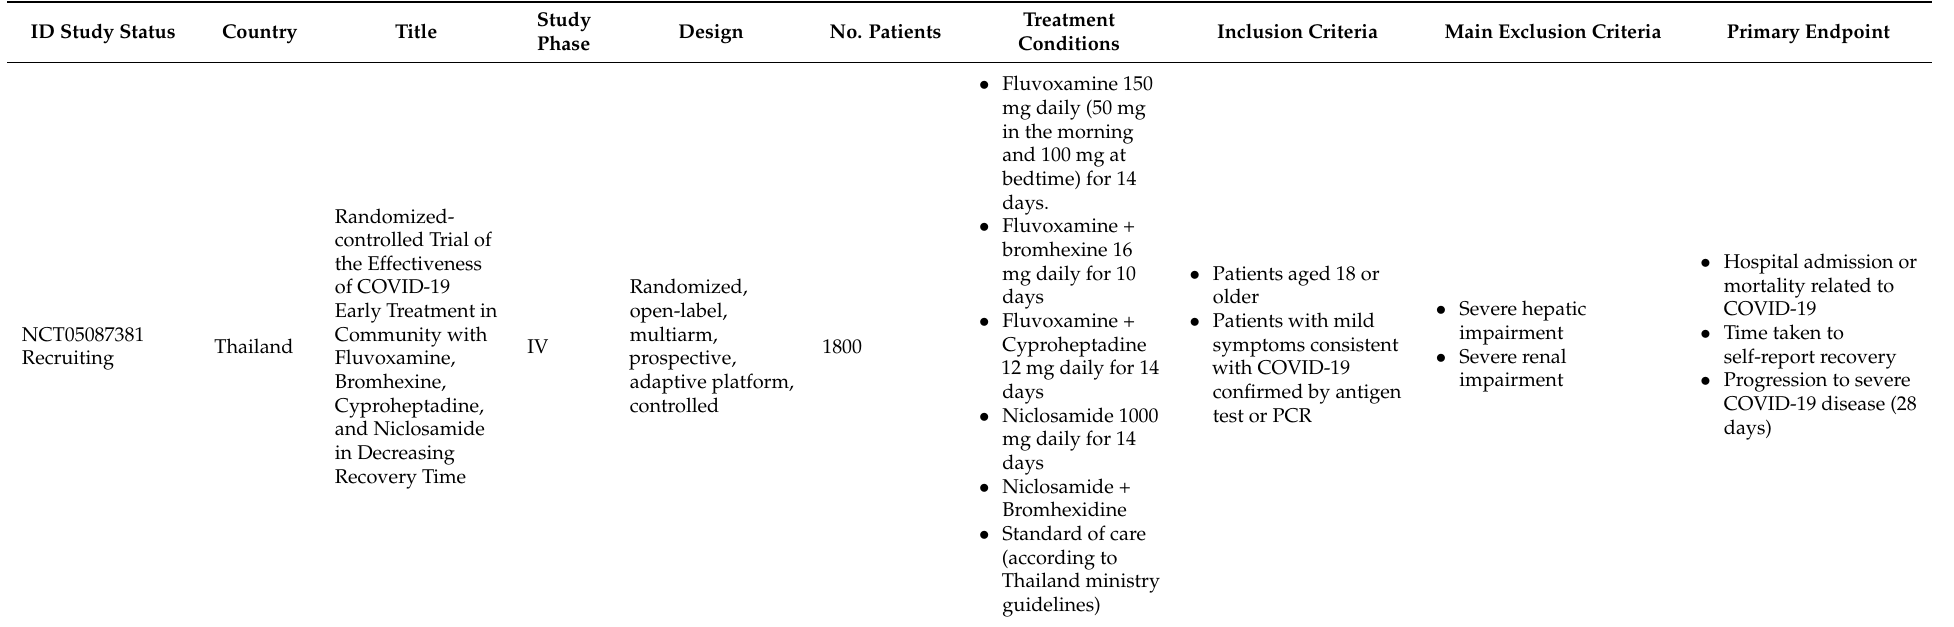
Table content extracted from clinicaltrials.gov. Only ongoing and completed studies have been